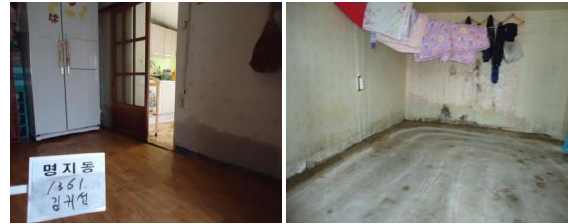
Figure 3. Flooded house’ wall and